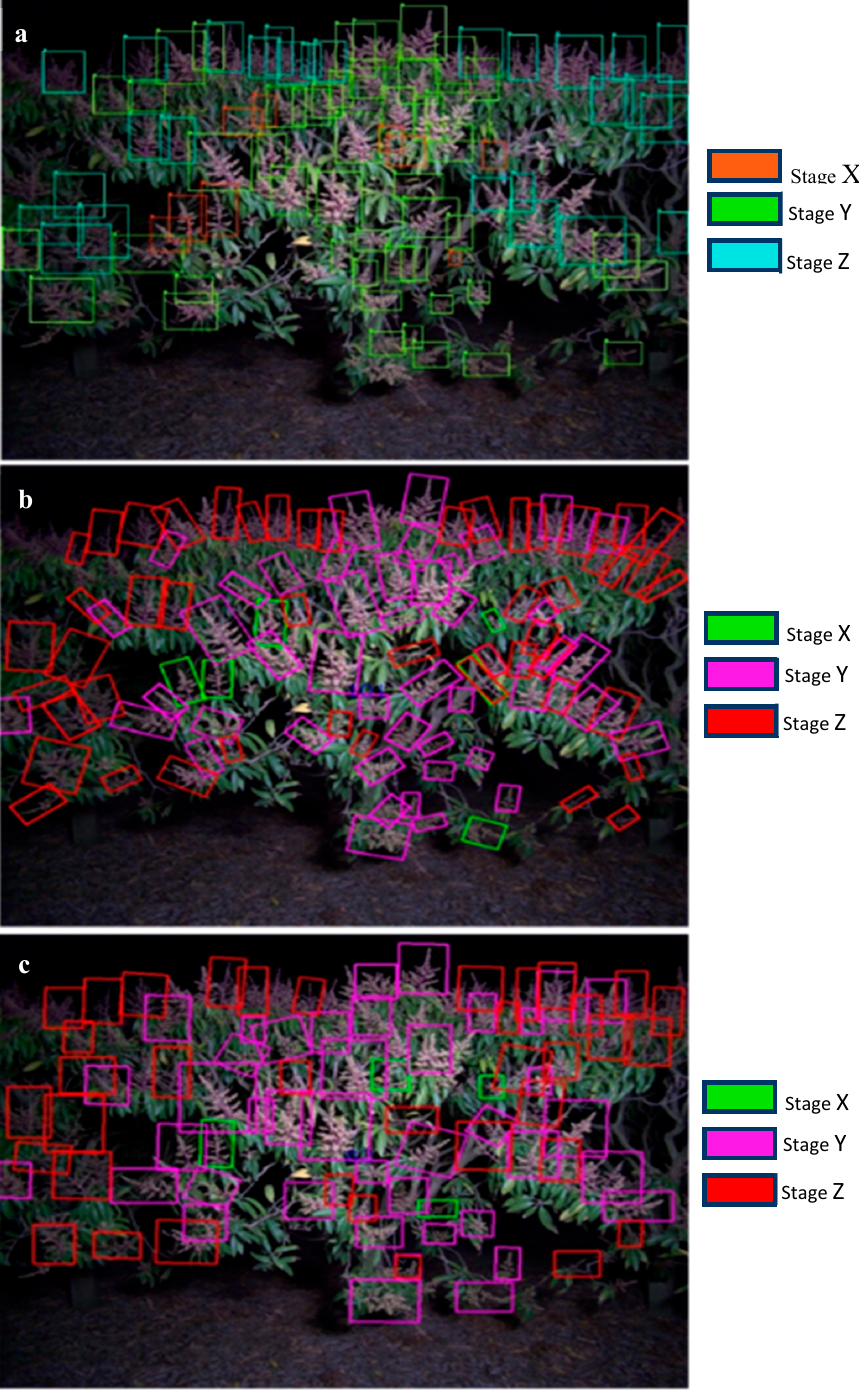
Figure 5. Image processed with three methods for panicle stage detection. ( a ) MangoYOLO-rotated method. Orange, green and blue coloured boxes represent panicle stages X, Y and Z respectively. ( b ) R 2 CNN(-rotated) and ( c ) R 2 CNN-upright methods, respectively. Green, pink and red coloured boxes represent panicle classes of X, Y and Z, respectively.